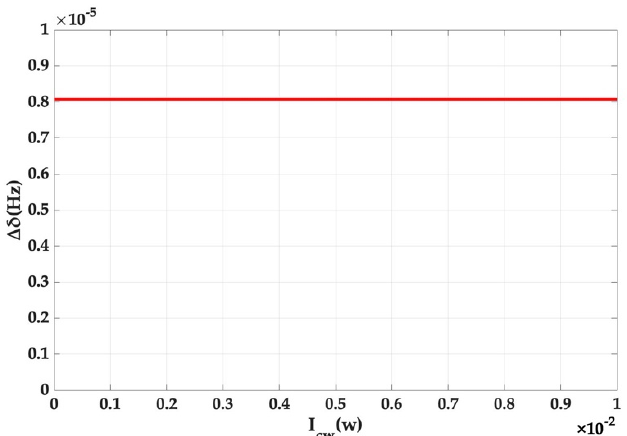
Figure 6. The relationship between the splitting value deviation and the angular rate for different distributions of light power.